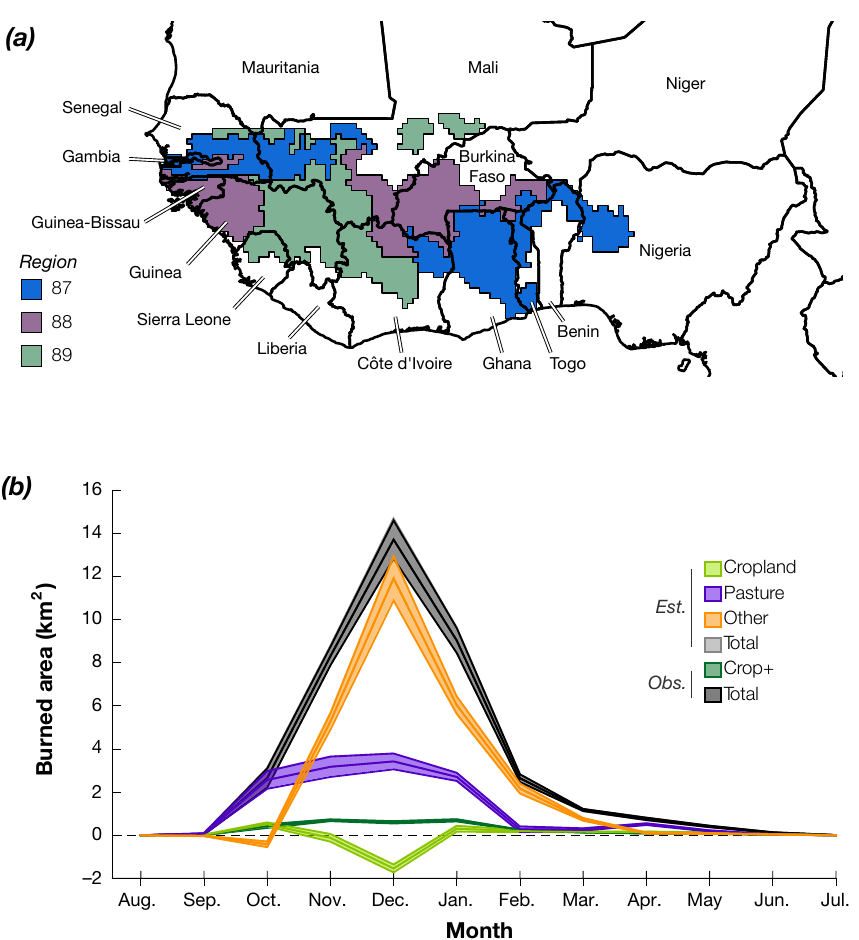
Figure 7. (a) Area included in the West African case study, color-coded by analysis region. (b) Mean seasonality of burned area in case study regions. Shading represents interannual variability ( ± 1SEM). Note that the x axis begins in August. Corresponds to Fig.